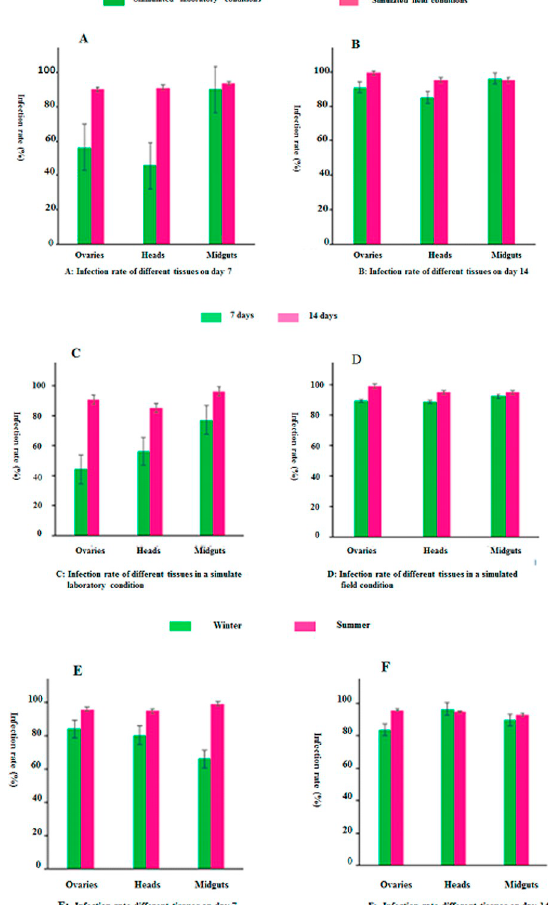
Fig 7. DENV-2 infection rate of Ae . albopictus . The experiment was divided into two groups, the simulated field environment group and the standard laboratory environment group. The simulated field environment groups was classed into simulated in summer and winter. Three factors, temperature, humidity, and light, were emphasized in the simulation of field environment in summer and winter, and the differences in the effects of these factors on mosquito infection with DENV virus were observed. (A) Infection rates of different tissues on day 7 in simulated field including summer and winter together. (B) Infection rates of different tissues on day 14 in simulated field including summer and winter together. C: Infection rate of different tissues in a simulate laboratory condition, D: Infection rate of different tissues in a simulated field condition, (E) Infection rates of different tissues on day 7 in simulated field in summer and winter. (F) Infection rates of different tissues on day 14 in simulated field in summer and